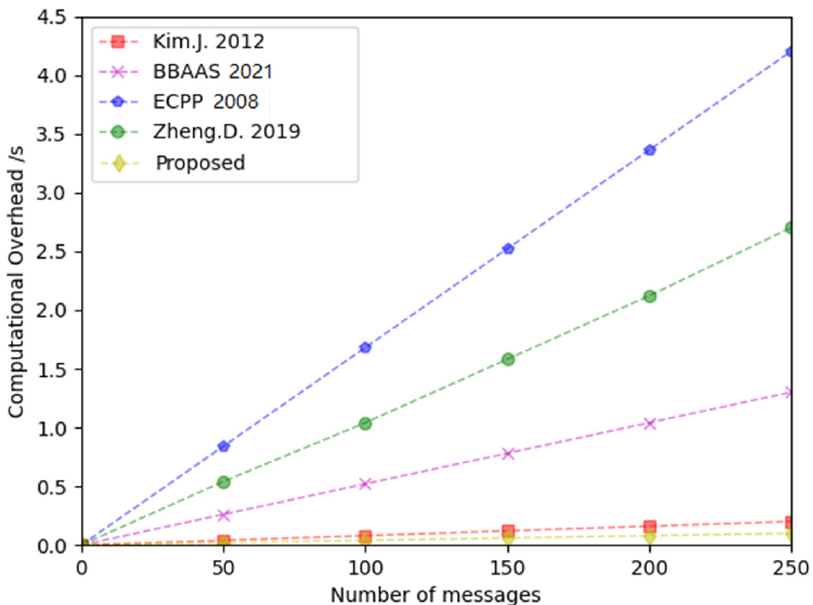
Figure 7. Computational overhead of the target RSU in the handover authentication phase [15,21,23,24].